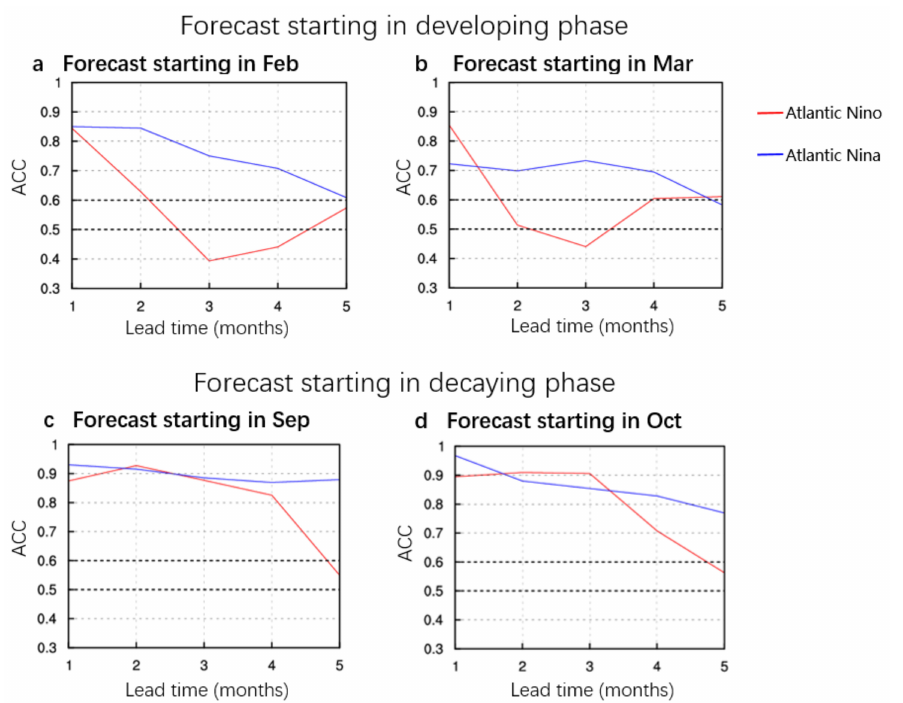
Figure 4. ( a , b ) The ACC of Atl3 index as a function of lead time ( x -axis) for the forecasts starting in the developing phase. Red (blue) line for the selected Atlantic Niño (Atlantic Niña) events. ( a ) and ( b ) for the forecast starting in February and March, respectively. ( c , d ) same as ( a , b ) but for the forecasts starting in the decaying phase, that is, ( c ) for September and ( d ) for